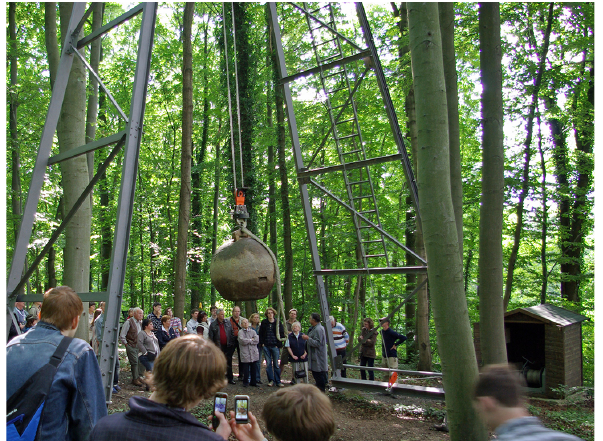
Figure 10. Preparation of the fall from about 14.5m above surface of the Mintrop-Kugel with a weight of 4t during a public tour in September 2010. Wolfgang Brunk (center next to the sca ff old) ex- plains the experiment to the interested audience. The hut with the winch can be seen to the right. Photo: Udo